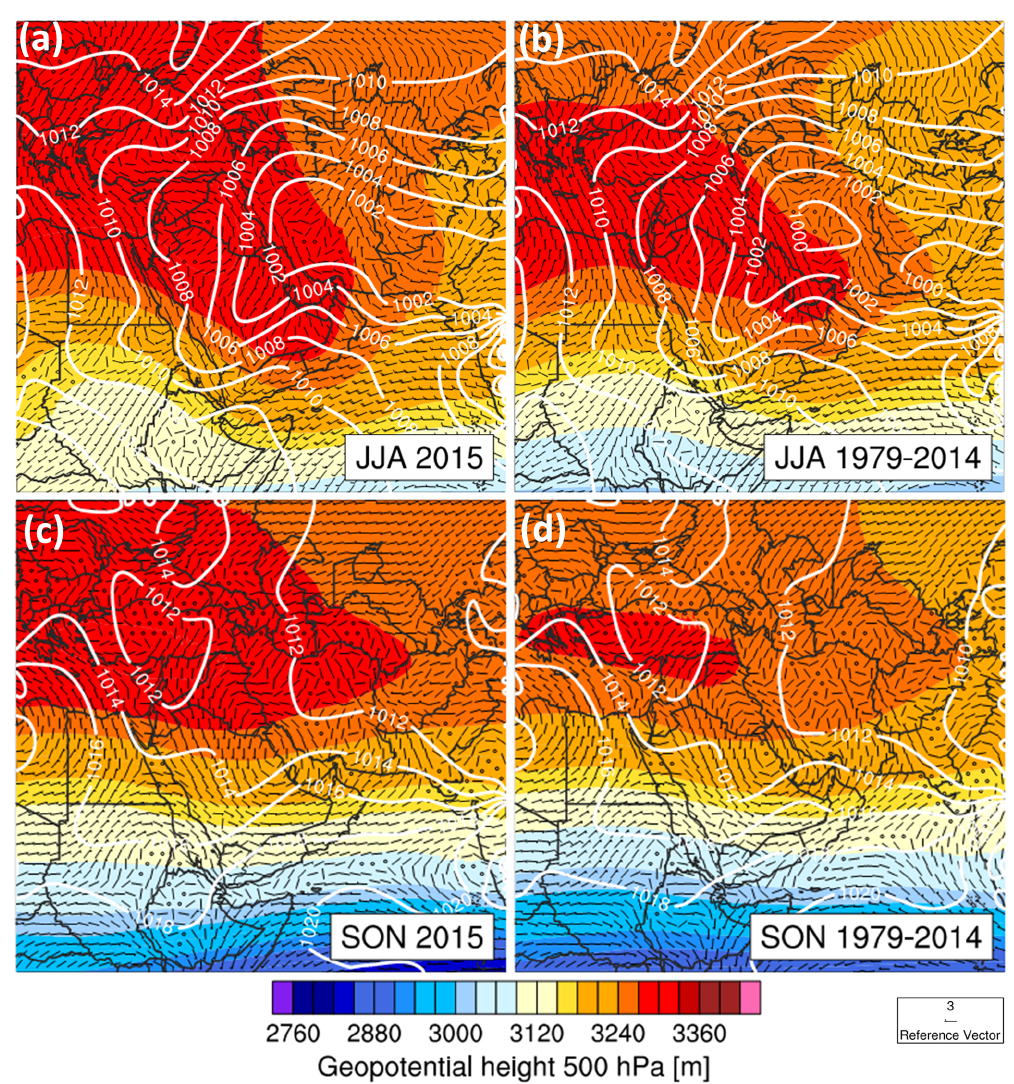
Figure 3. As for Fig. 2 but for summer and autumn: June–August ( a , b ) and September–November ( c , d ). Data were also taken from the ECMWF ERA5 reanalysis